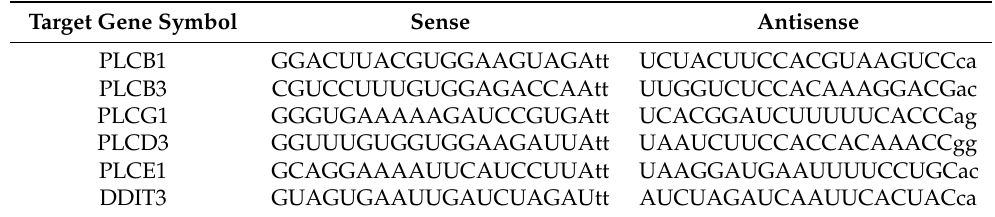
Table 1. Silencer Select Pre-Designed siRNA sequences (5 (cid:48) –3 (cid:48) ). Target Gene